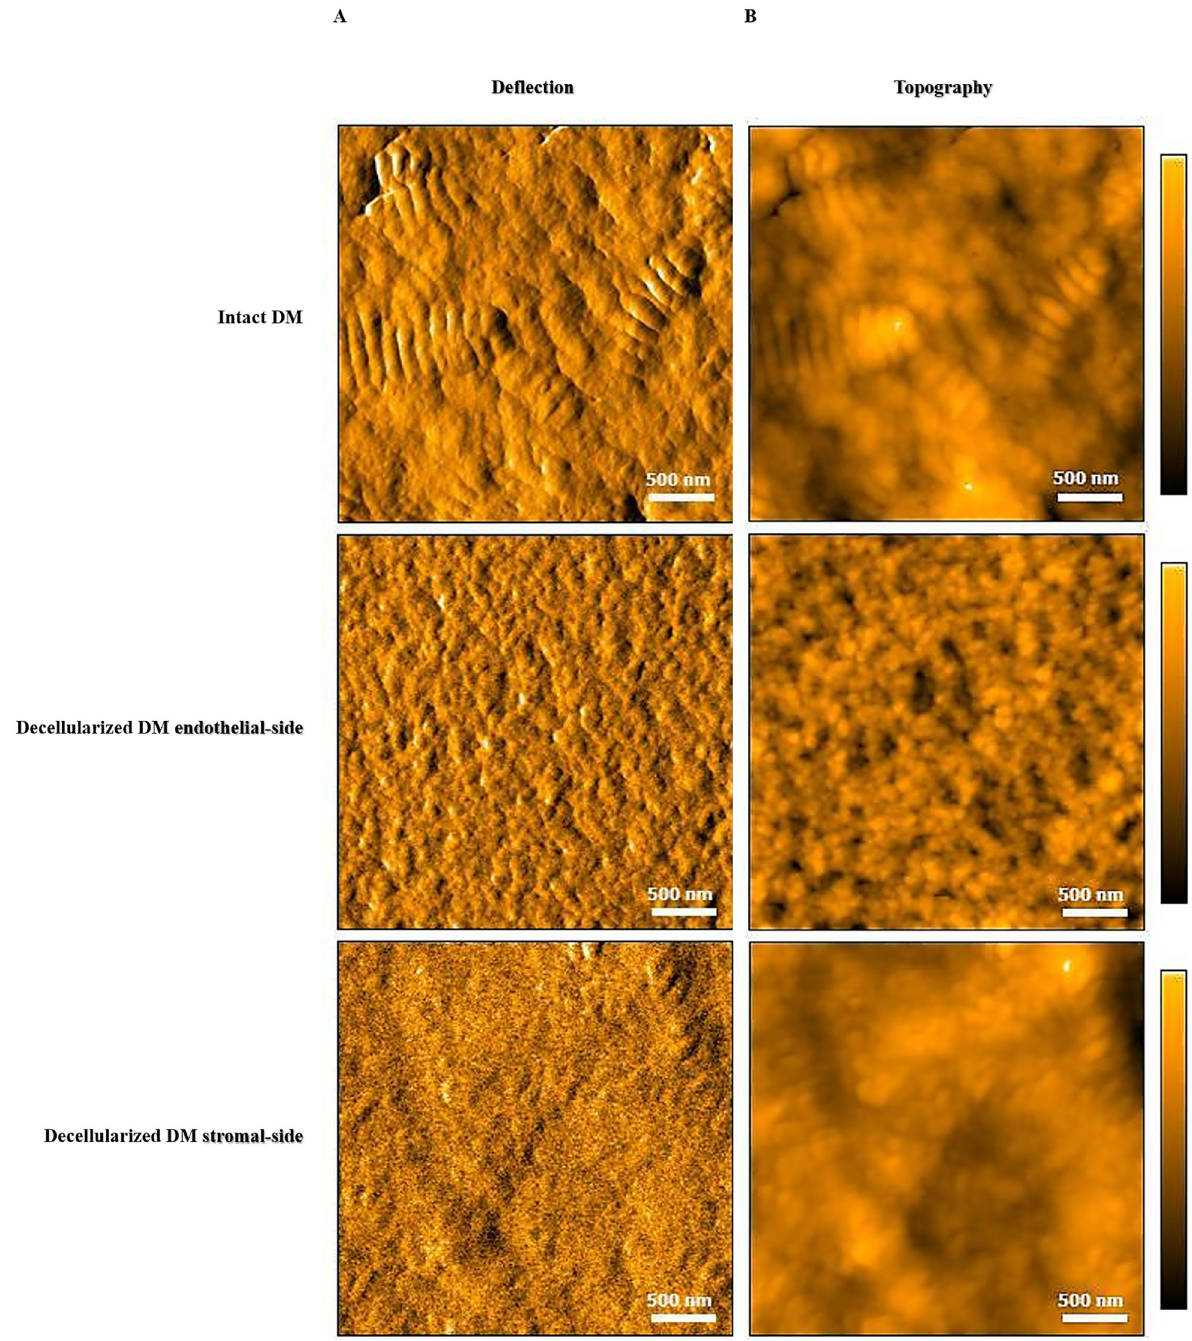
Fig 2. AFM analysis of Descemet’s membrane’s surface before and after decellularization. AFM images representing ( A ) deflection and ( B ) topography of intact and denuded tissue. Image scale: 3 x 3 μ m. The coloured bars depict the height. Scale bars = 500nm. DM, Descemet’s membrane.